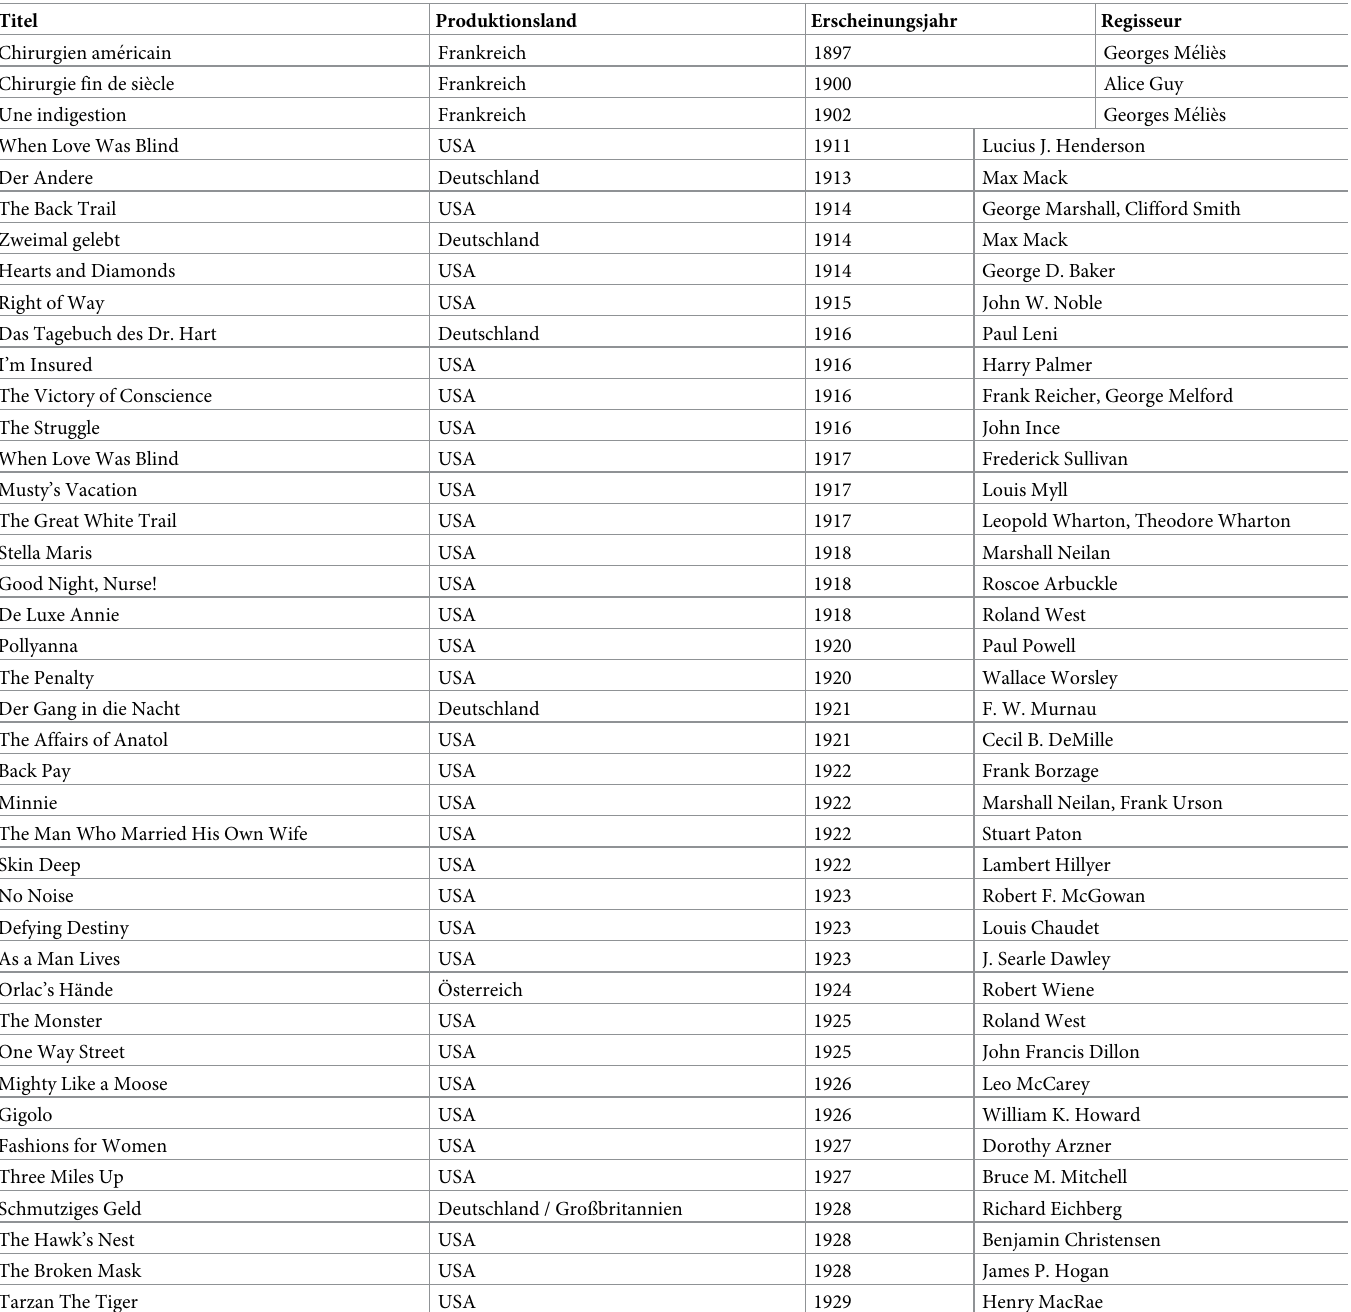
Table 1. Chronological list of analyzed